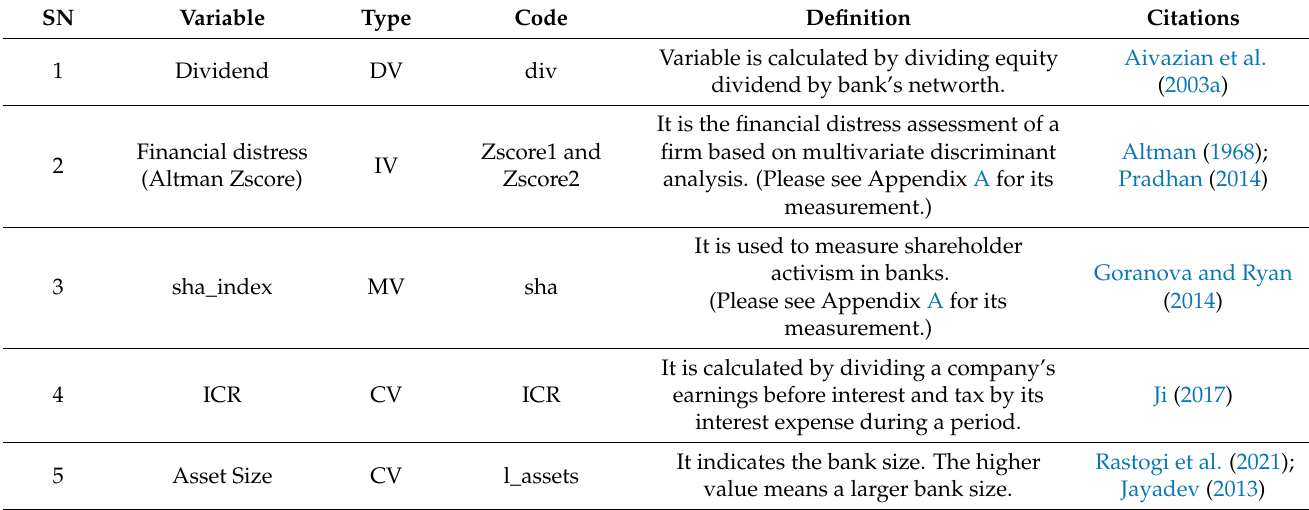
Table 1. Description of